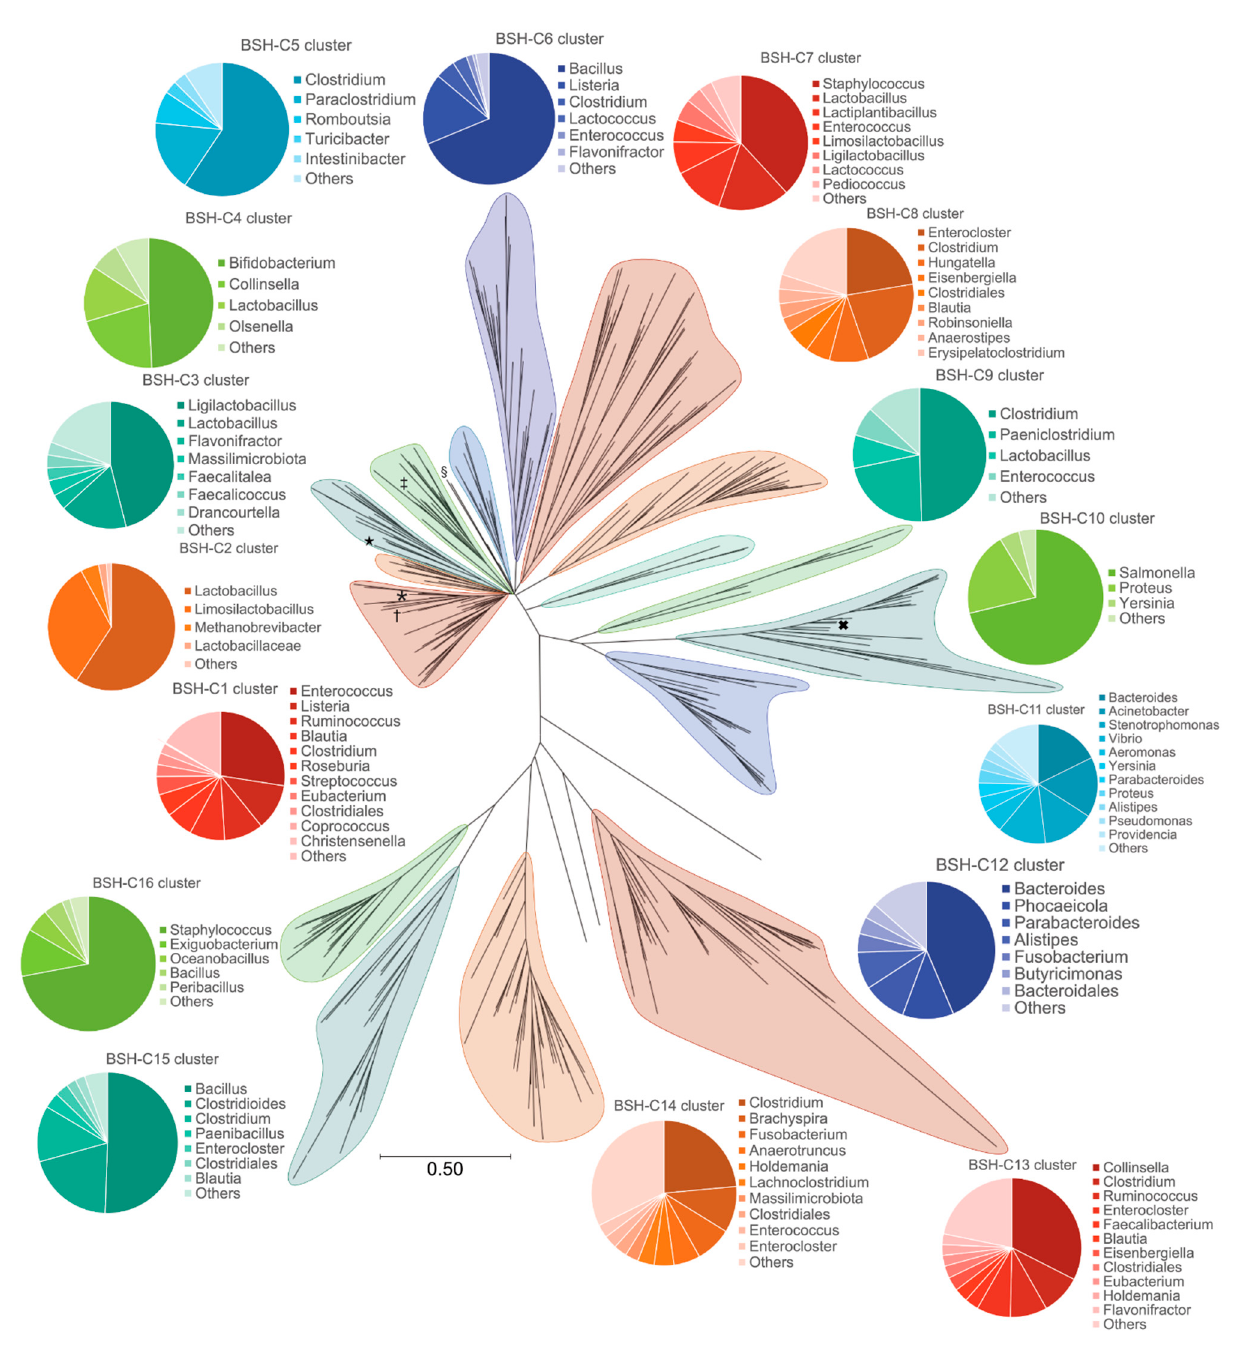
Figure 5. Phylogenetic tree of BSHs from the human gut. A dataset of 6701 BSH sequences from the human gut was selected and processed as described in the Materials and Methods section. Pie charts around the tree show the count of sequences belonging to the mentioned genera for each BSH cluster (see Table S6 for raw data). The asterisk indicates the approximate position of the Christensenellaceae branch. The symbols show the approximate position of branches where characterized BSH can be found (†: WP_002355428.1 with PDB structure 4WL3; §: WP_003461725.1 with PDB structure 2BJF; ‡: WP_013410903.1 with PDB structure 2HF0; ★ : WP_047036229.1; with PDB structure 5HKE; ✕ : WP_008761025.1 with PDB structure 6UFY).